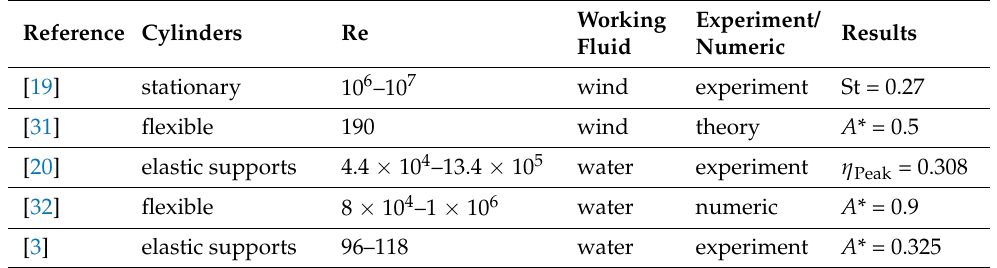
Table 1. Representative studies.